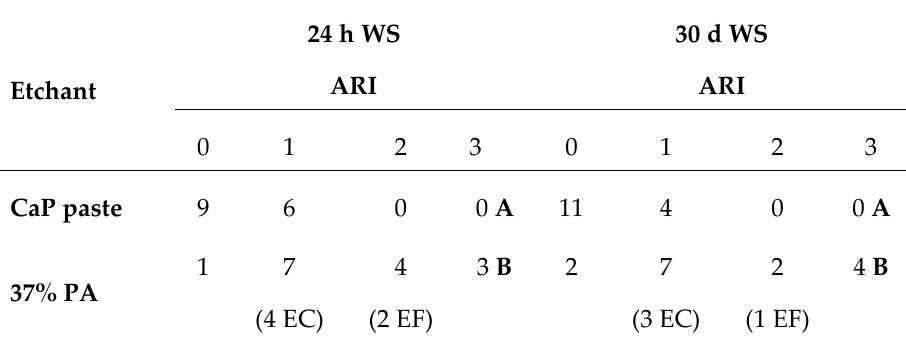
Table 2: ARI scores after 24 h and 30 d WS for control and experimental